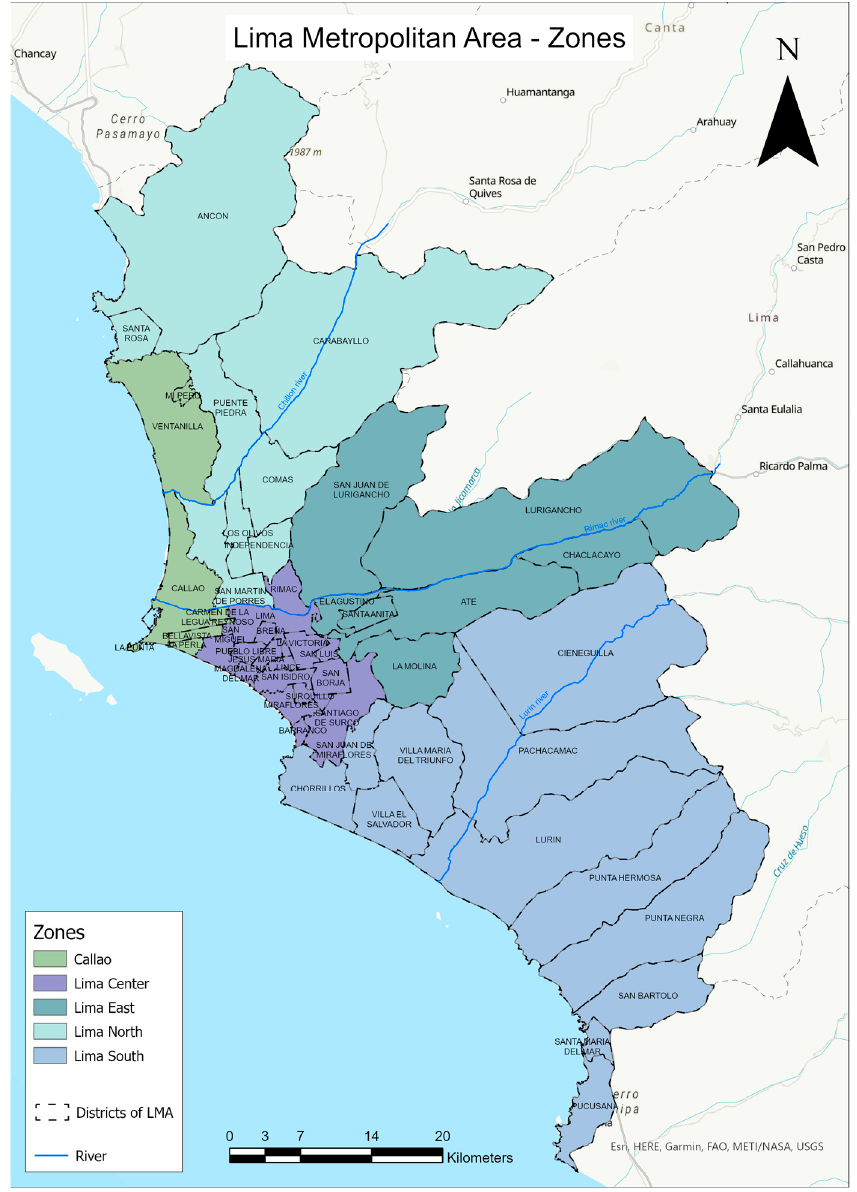
Figure 1. Lima Metropolitan Area. The territory is divided into five zones and 51 districts.